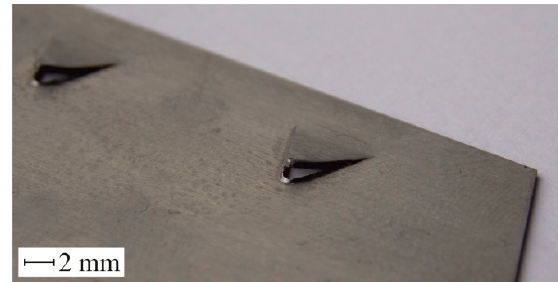
Figure 2. View of triangular hooks obtained by partial blanking.